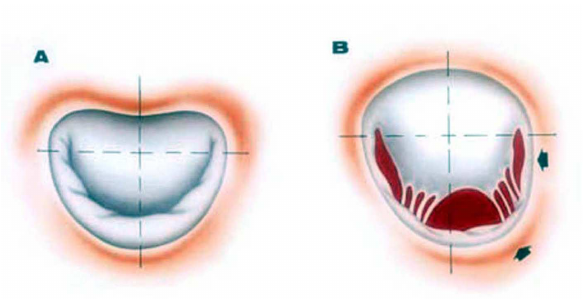
Fig. 10 – A: normal mitral valve annulus. B: posterior dilation of the annulus and to a greater extent next to the posteromedial commissure (arrows)